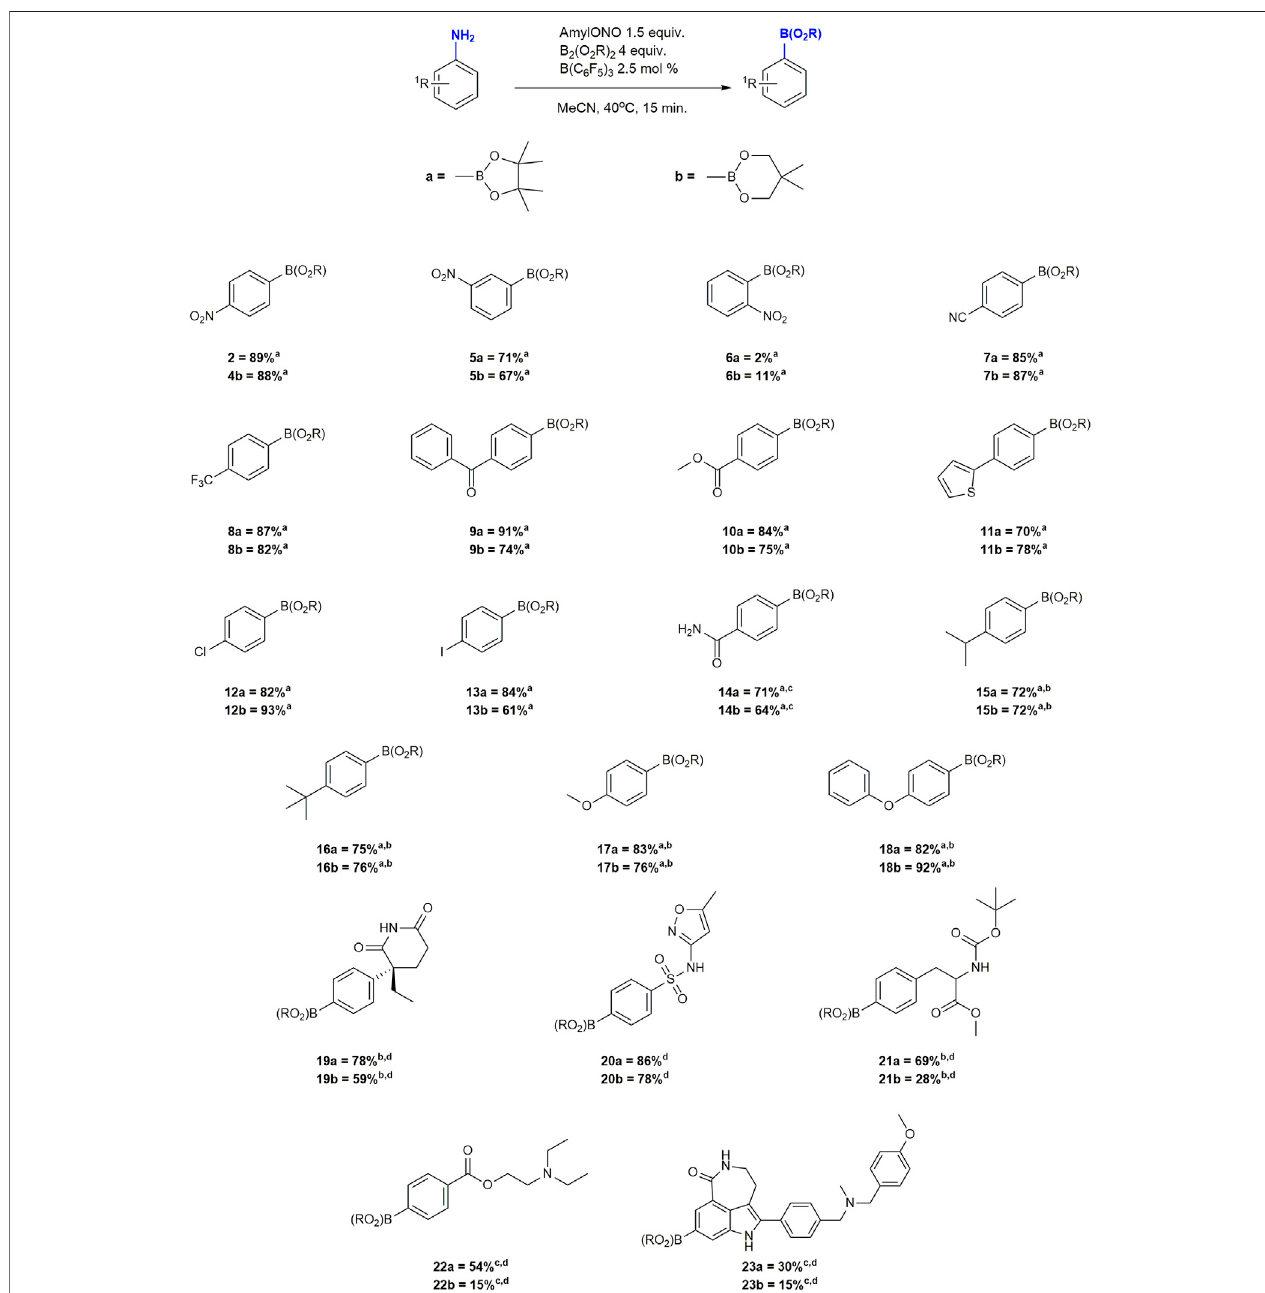
FIGURE 1 | Substrate scope of the borono-deamination reaction. a Yield determined by 1 H-NMR spectroscopy. b Reaction performed at 80 ° C. c AcOH (4 equiv.) added as an additive. d Isolated yield.